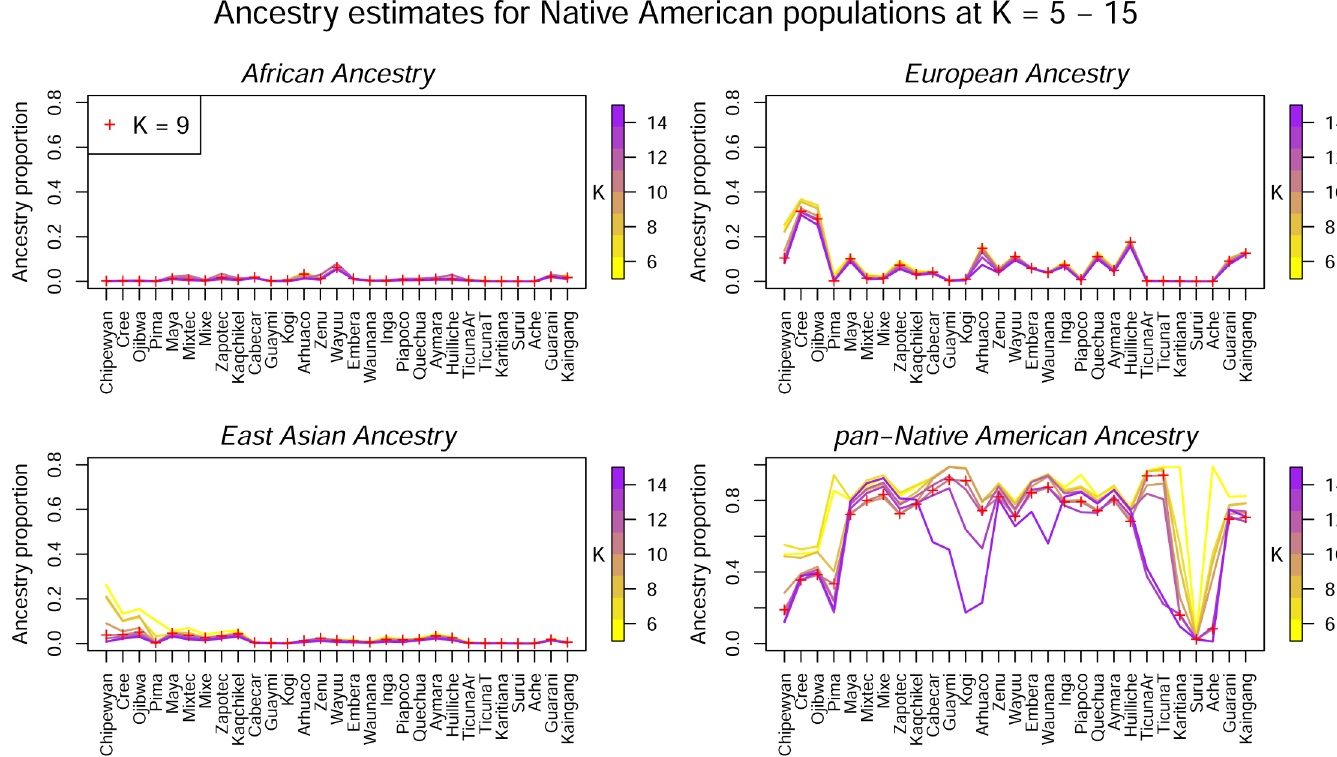
Fig 2. Ancestry estimates within each population at values of K from 5 – 15. The lines are color coded according to the values of K , with low values in yellow and high values in purple. The red ‘ + ’ signs show the estimates at K = 9.